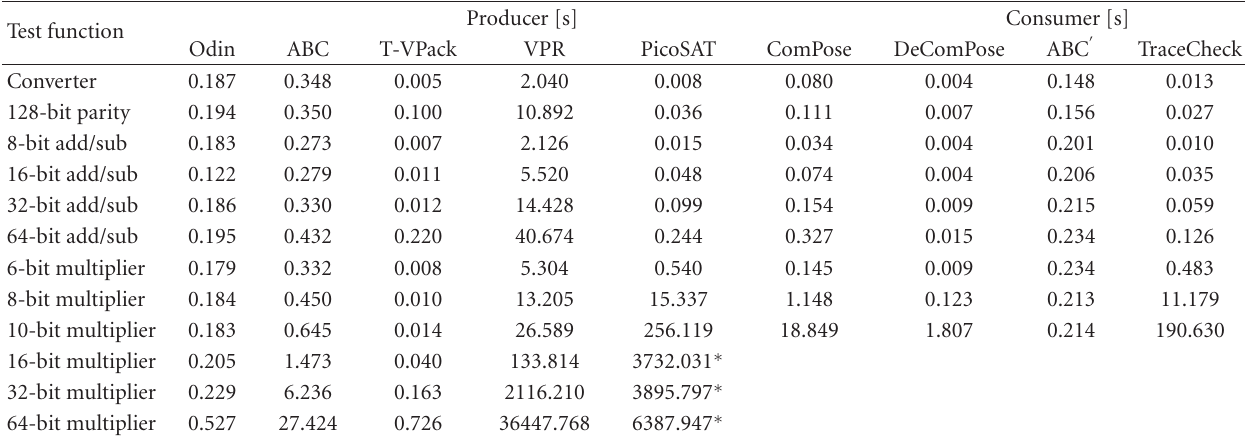
Table 2: Runtime measurements for producer and consumer in the online CEC scenario. Test